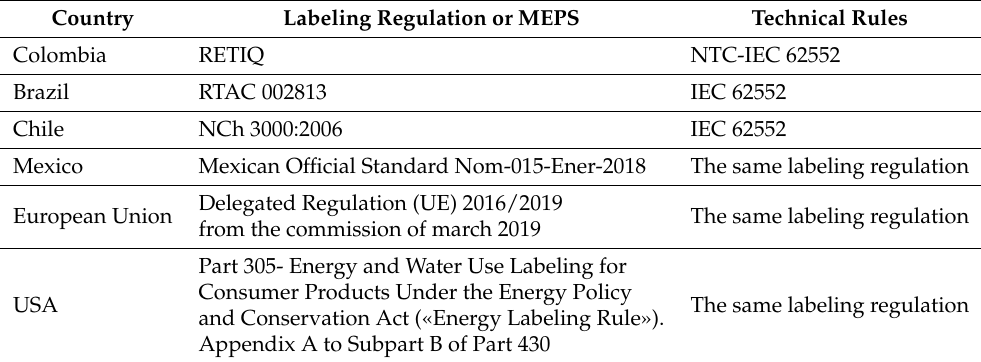
Table 1. List of labeling regulations by country.